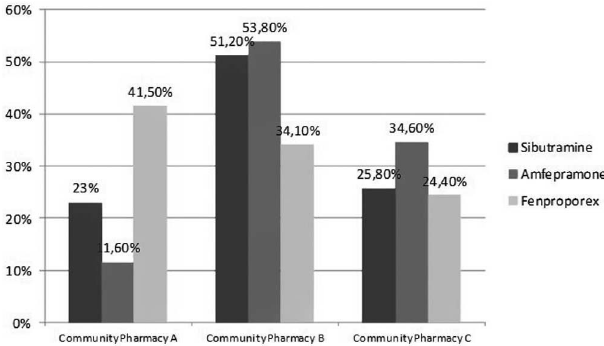
FIGURE 3 - Anorectics dispensation frequency in community pharmacies A, B e